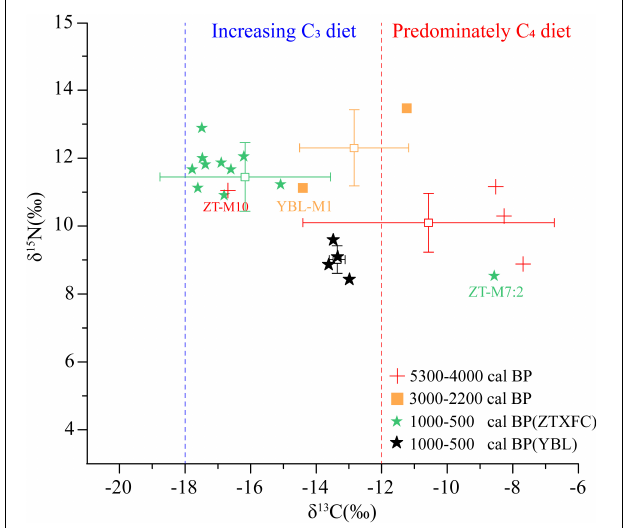
FIGURE 3 | Comparison of the δ 13 C and δ 15 N results with scatter and mean ± SD for humans from sites of the middle and lower reaches of the Hulu River Valley during three